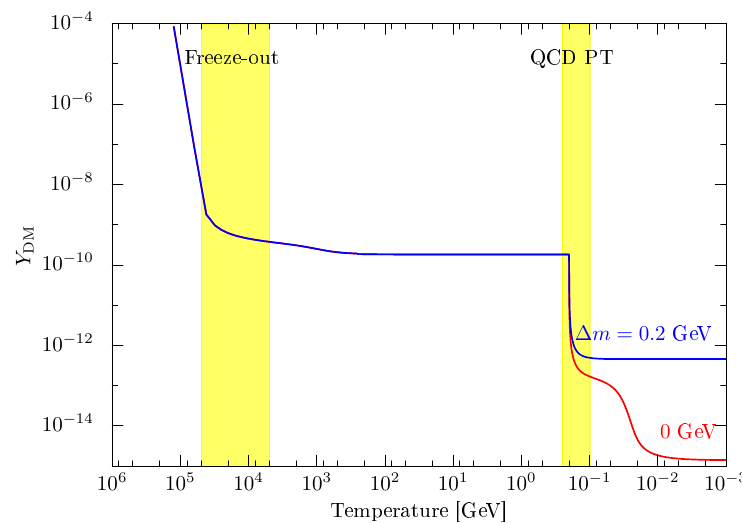
6 GeV. The red DM = 10